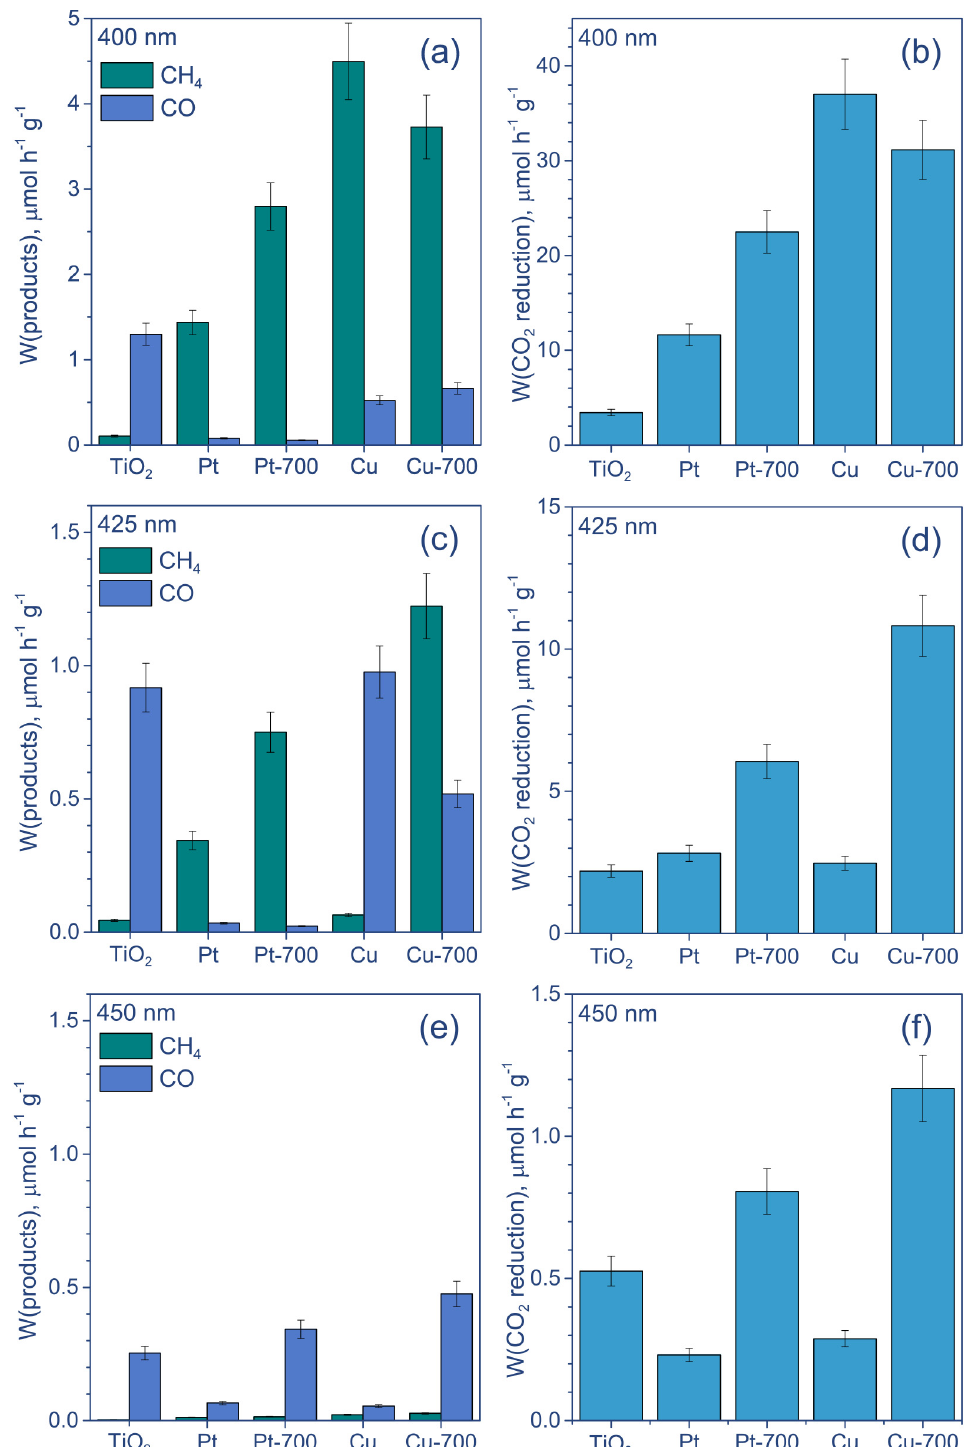
Figure 5. The results of activity study of photocatalytic reduction of CO 2 under irradiation by light of ( a , b ) LED-400 nm, ( c , d ) LED-425 nm, and ( e , f ) LED-450 nm. Conditions: m(cat.) = 30 mg, P 0 (CO 2 ) = 1 atm, t = 24 h. Designation: “Pt” and “Cu” means Pt/TiO 2 and Cu/TiO 2 , respectively; “Pt-700” and “Cu-700” means Pt/TiO 2 700 and Cu/TiO 2 700, respectively. According to the results of UV-Vis spectroscopy, Cu/TiO 2 and Cu/TiO 2 700 absorb visible light to varying degrees, but light absorption in this region indicates the presence of copper oxides in both samples. This assumption was clearly confirmed by the XPS